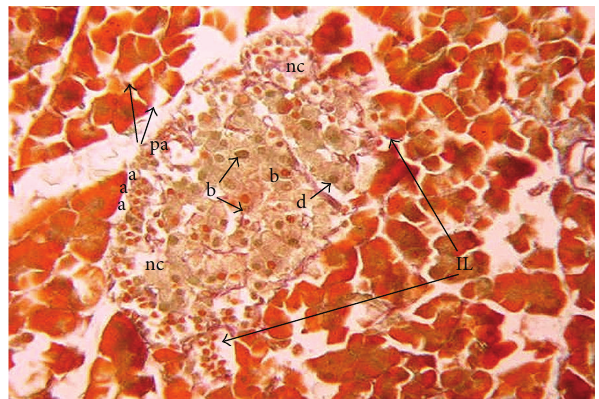
Figure 2: Photomicrograph of pancreas section of diabetic rat offspring just after birth showing disturbed islets of Langerhans (IL) with necrosis (nc) and vacuolations (v). Beta cells (b) are hypertrophied, but low in number. Alpha (a) cells are large in number compared to their corresponding control, (pa) pancreatic acini ( ×